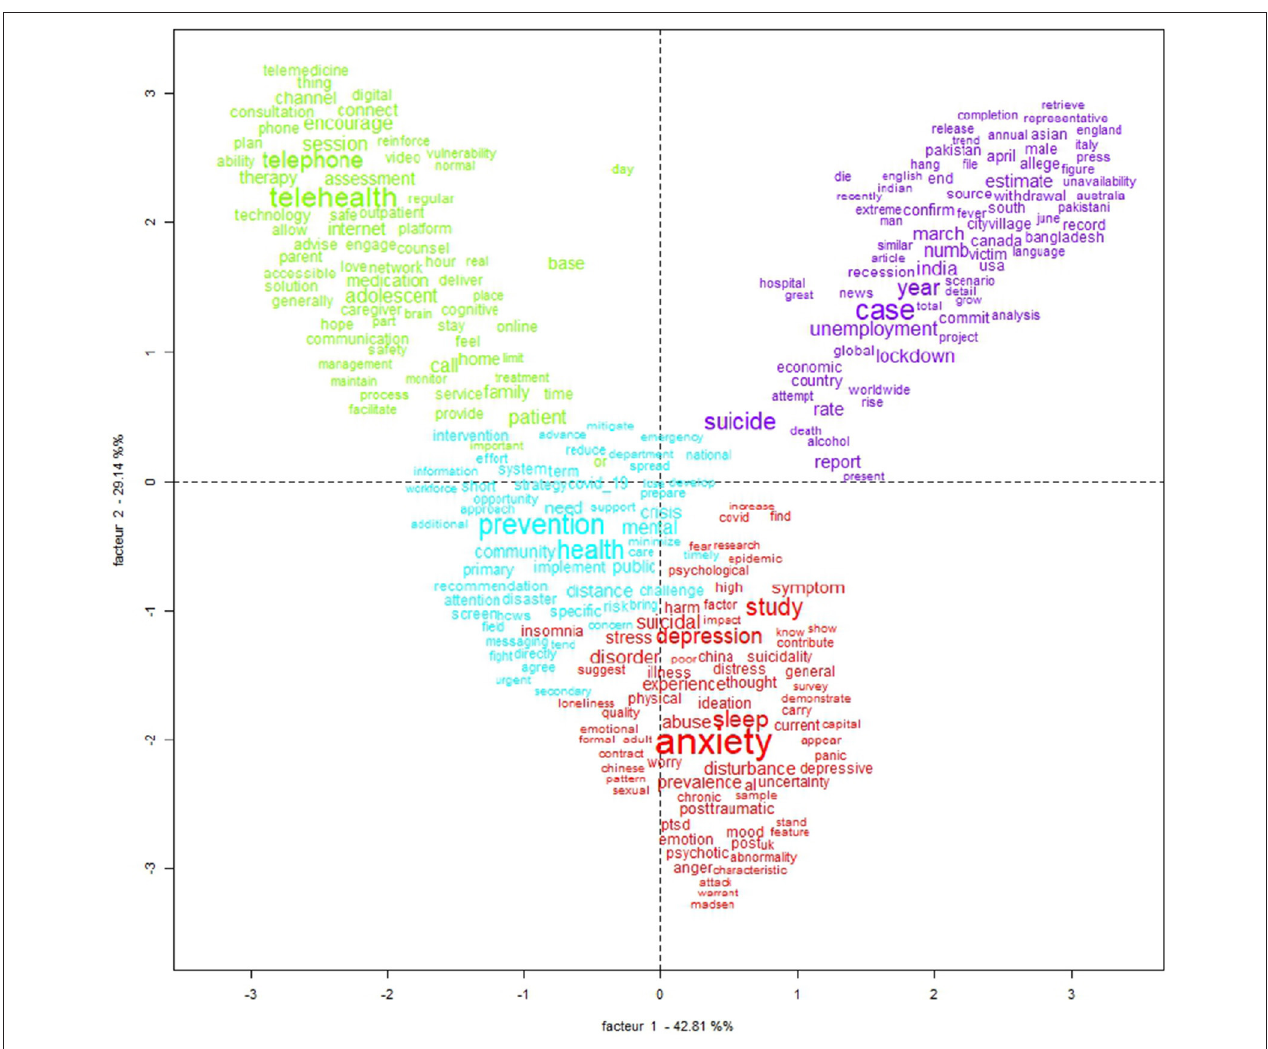
FIGURE 2 | Correspondence factorial analysis (CFA)